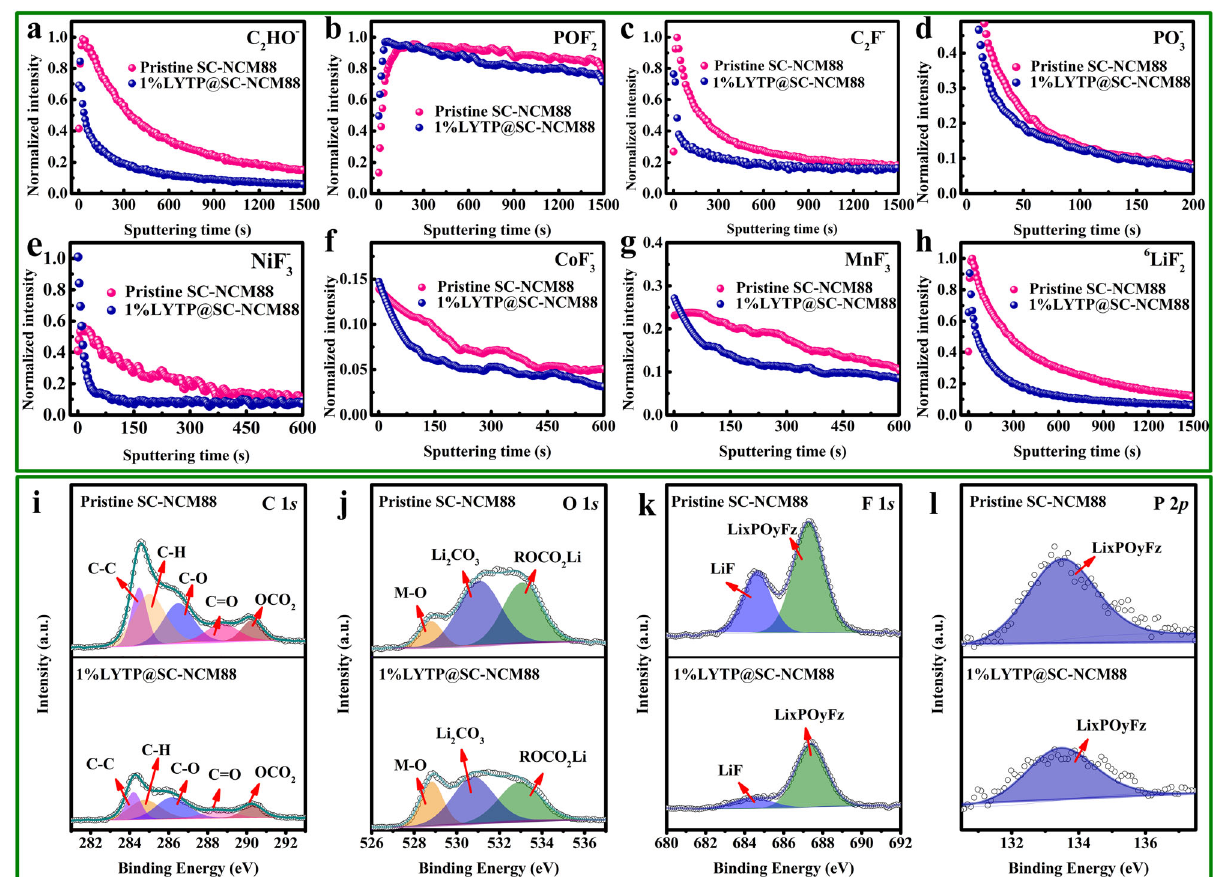
Fig. 8 Ex situ surface chemistry characterizations of cycled pouch cell positive electrodes. TOF-SIMS depth pro fi les of the near-surface chemical composition for ( a ) C 2 HO − , ( b ) POF 2 − , ( c ) C 2 F − , ( d ) PO 3 − , ( e ) NiF 3 − , ( f ) CoF 3 − , ( g ) MnF 3 − and ( h ) 6 LiF 2 − . XPS spectra of ( i ) C 1 s , ( j ) O 1 s , ( k ) F 1 s and ( l ) P 2 p elements for the pristine SC-NCM88 and 1% LYTP@SC-NCM88 cathodes after 200 cycles from 2.7 V to 4.4